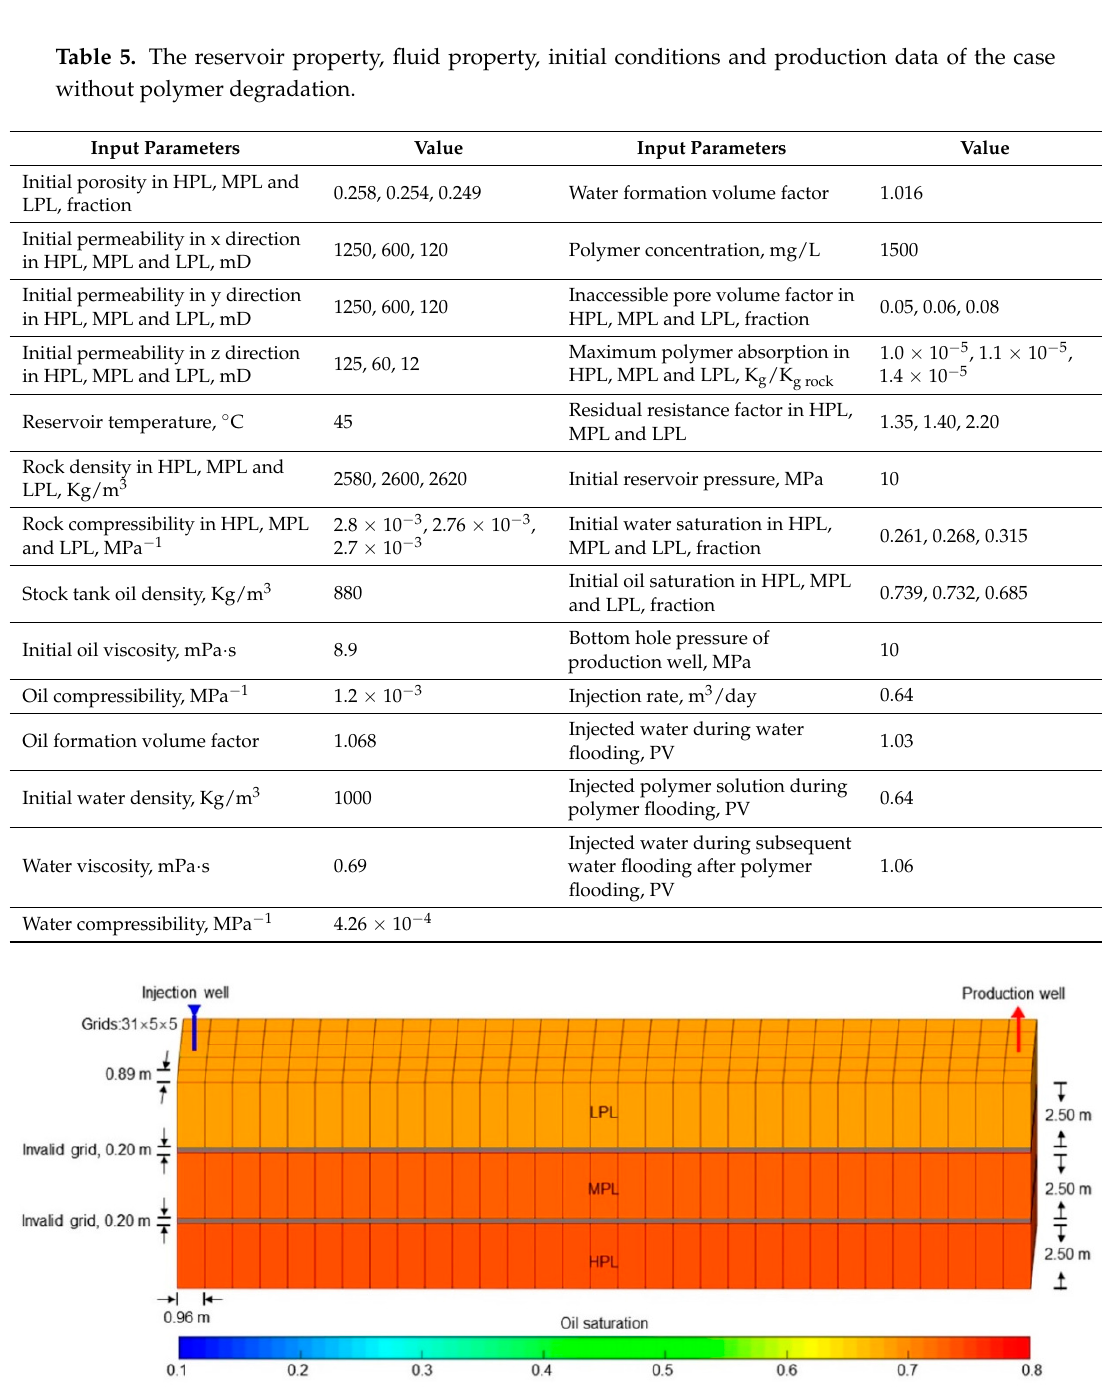
Table 5. The reservoir property, fluid property, initial conditions and production data of the case without polymer degradation.